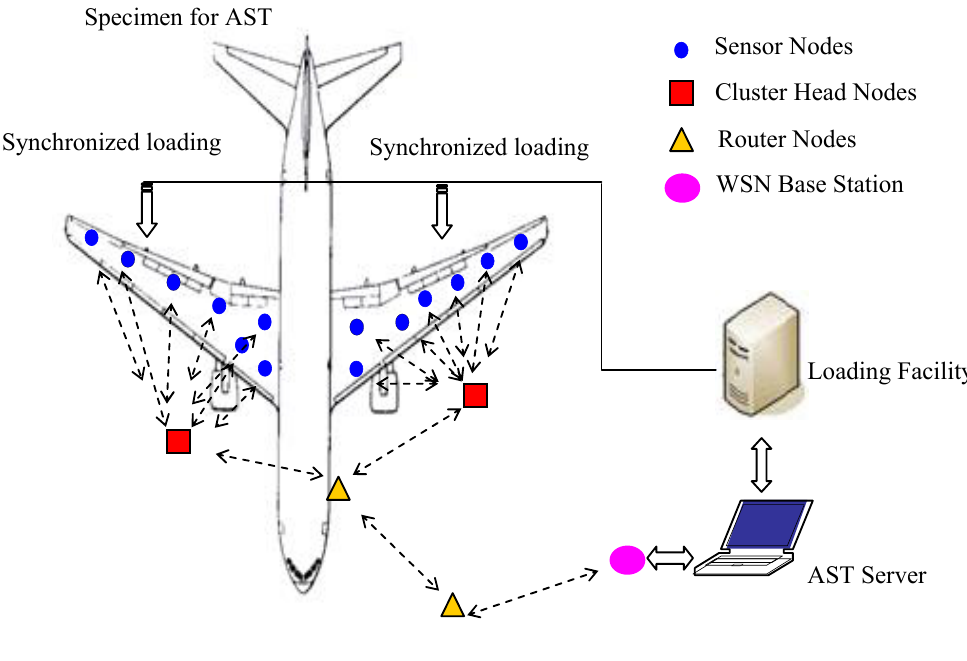
Figure 1. The WSN framework for